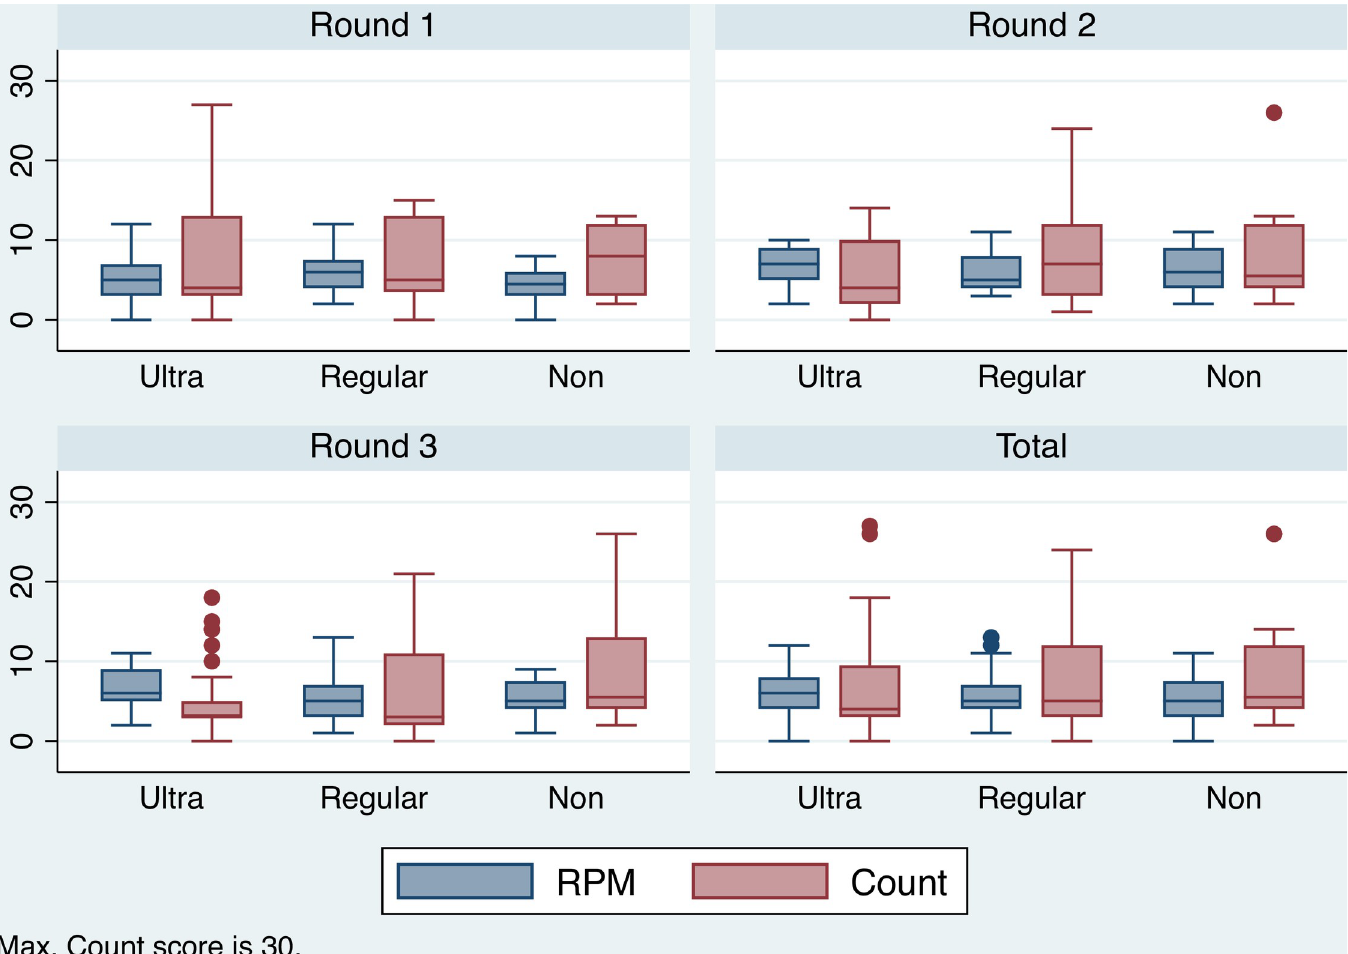
Fig 4. Distribution of RPM and Count scores by poverty level. Boxplot showing the relationship between RPM, Count and poverty levels, across survey rounds (Count max. 30).